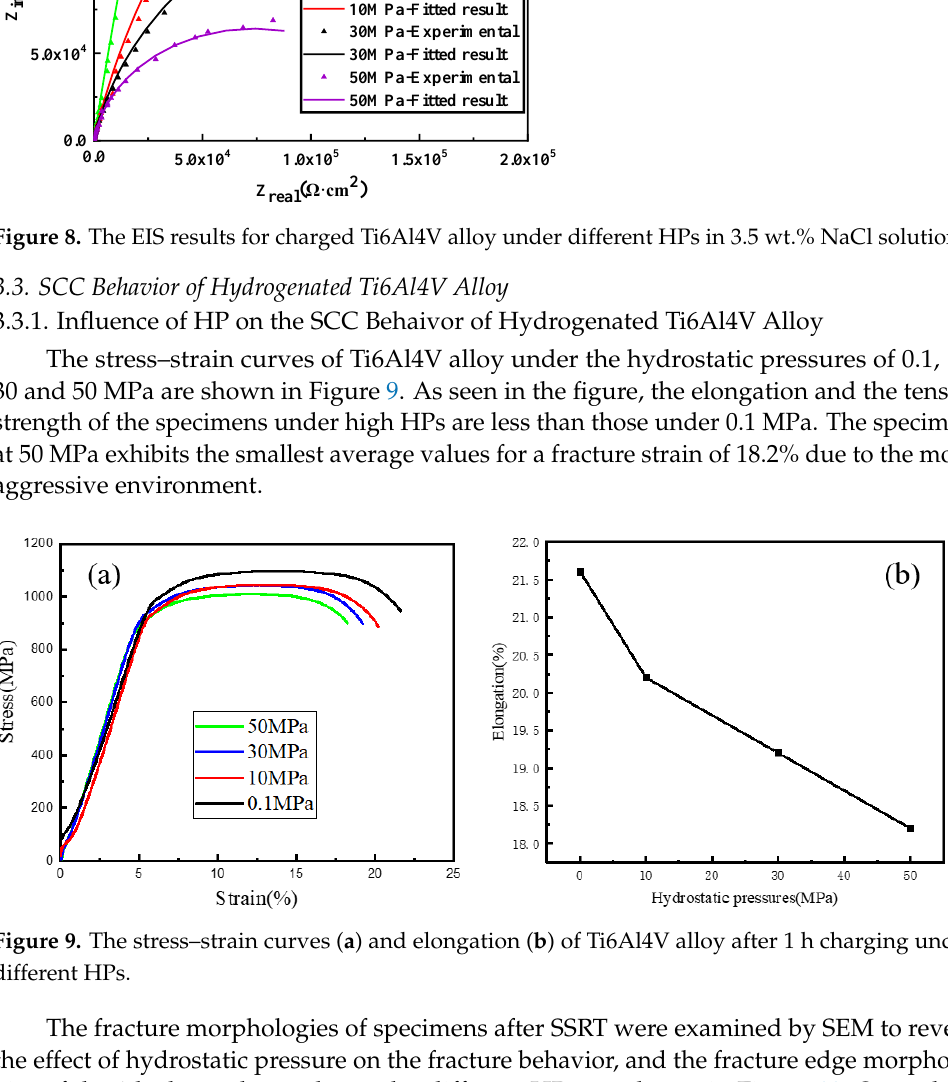
Figure 8. The EIS results for charged Ti6Al4V alloy under different HPs in 3.5 wt.% NaCl solution.